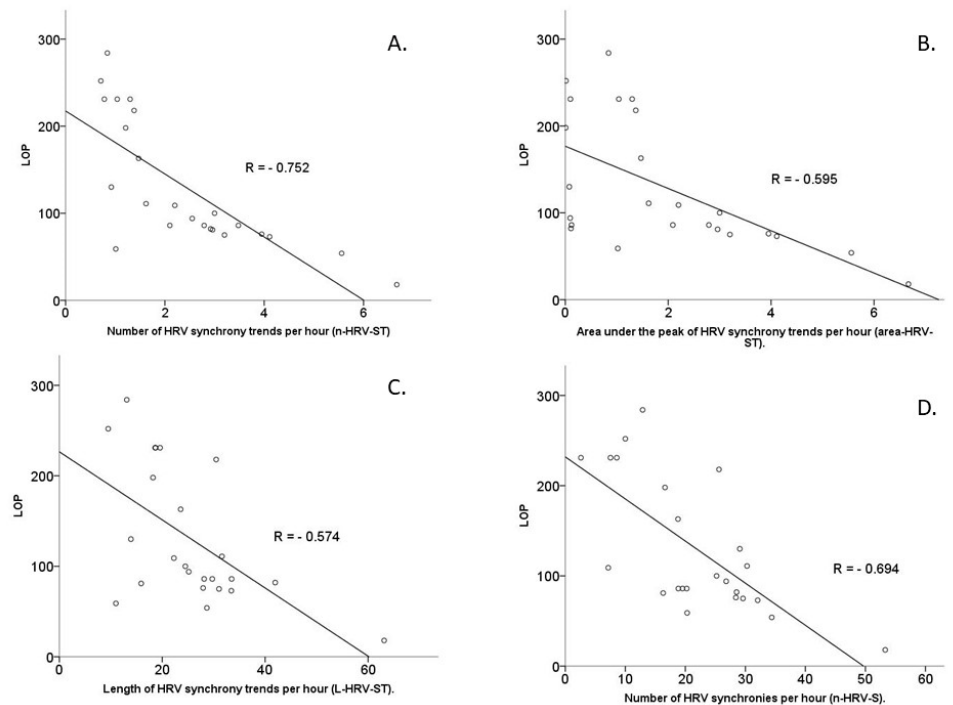
Figure 3. Correlations between LOP and number of HRV synchrony trends per hour ( A ), area under peak of HRV synchrony trends per hour ( B ), length of HRV synchrony per hour ( C ) and number of HRV synchronies per hour ( D ).